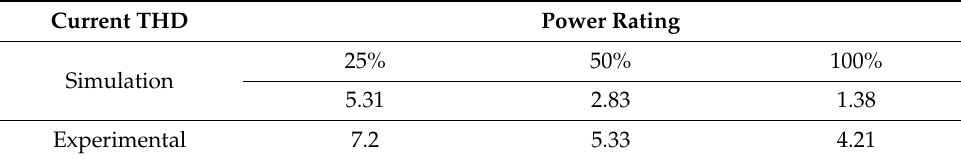
Table 5. Converter current THD.